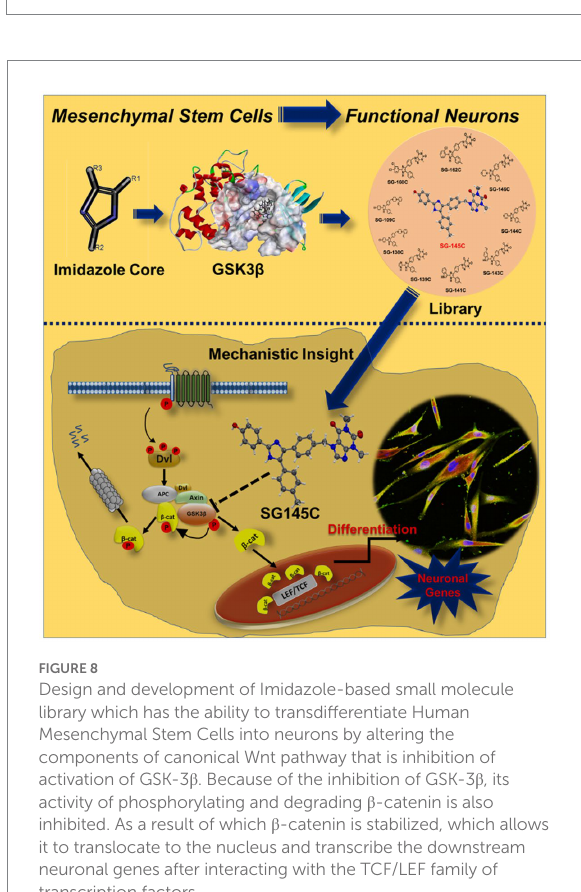
FIGURE 7 SG-145C induced trans-differentiation proceeds via the Wnt pathway. (A) qPCR and (B,C) immunoblot analysis comparing the expression of neuron- specific genes in response to SG-145C in combination with Wnt pathway inhibitor NSC668036 and commercially available GSK-3 β inhibitor CHIR99021. (D) ICC staining was performed to compare the level of trans-differentiation in response to the mentioned inhibitors in combination with SG-145C. β -III Tubulin (AF-488) was used as neuronal marker proteins for visualization. Images were captured in 20X magnification where the scale bar corresponds to 70 μm. n = 3 for all sets of experiments and significance was calculated using one-way Anova * p < 0.05, ** p < 0.01, *** p <